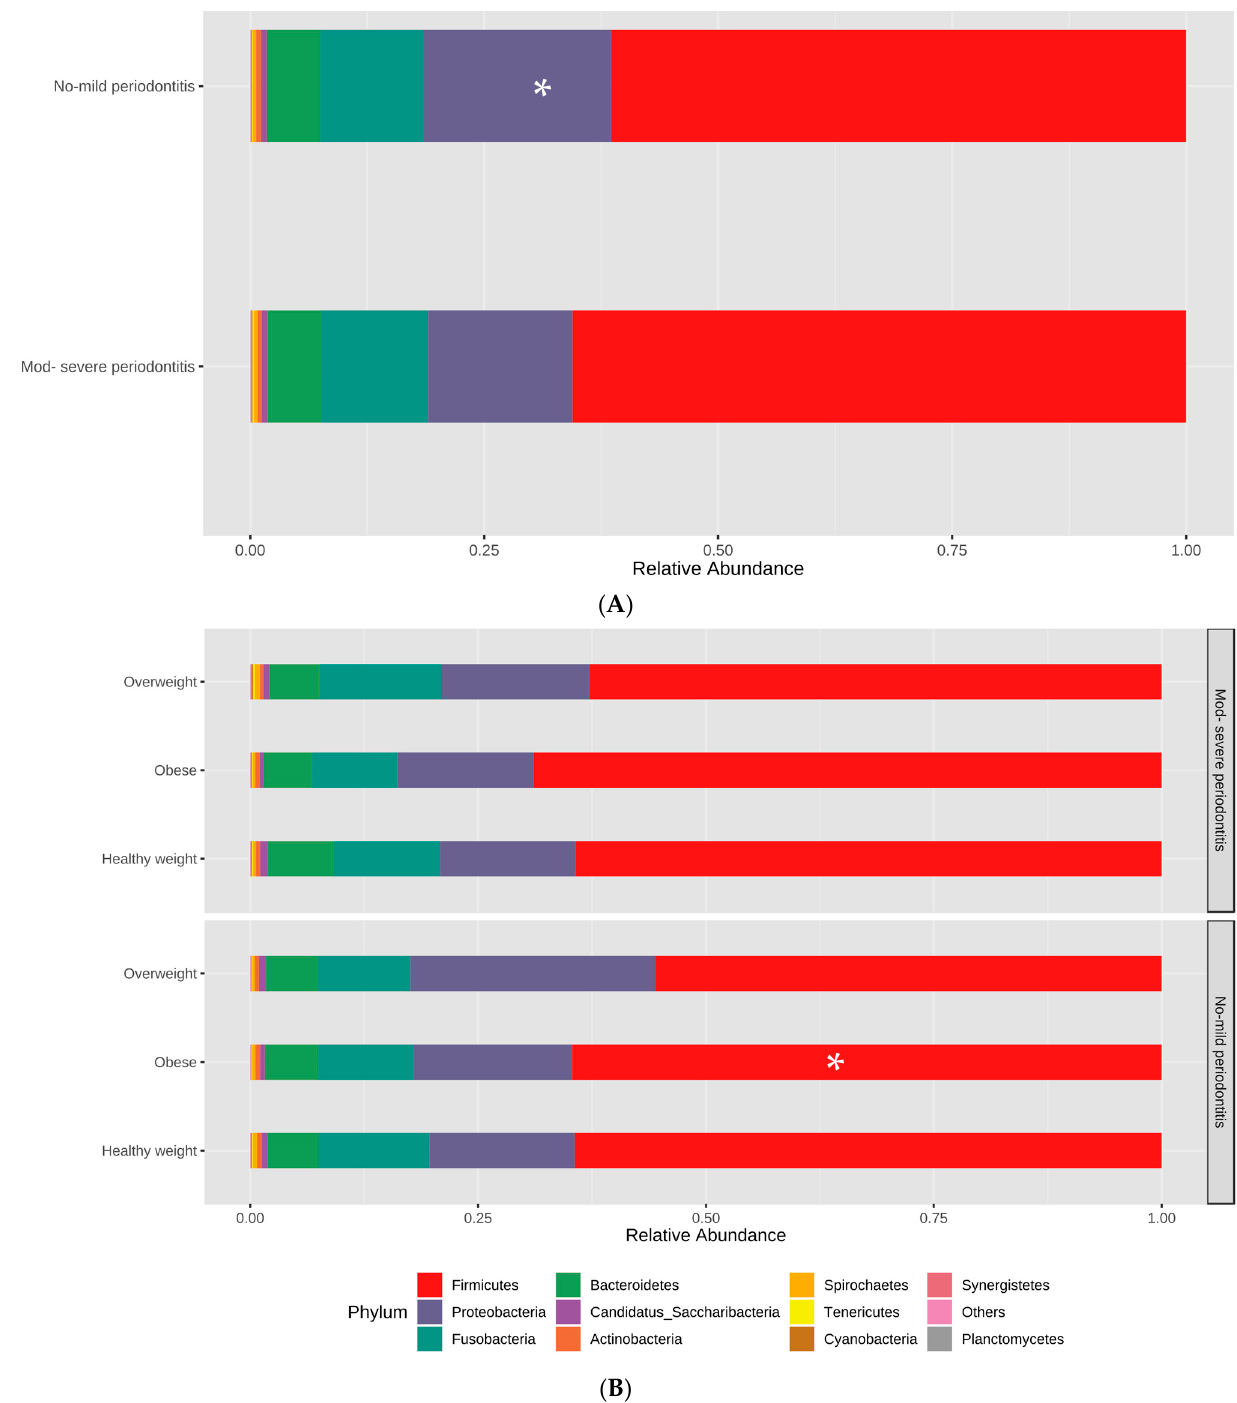
Figure 1. Relative abundance of phyla detected in the participants grouped based on the periodontal health status ( A ), then sub-grouped based on BMI ( B ).